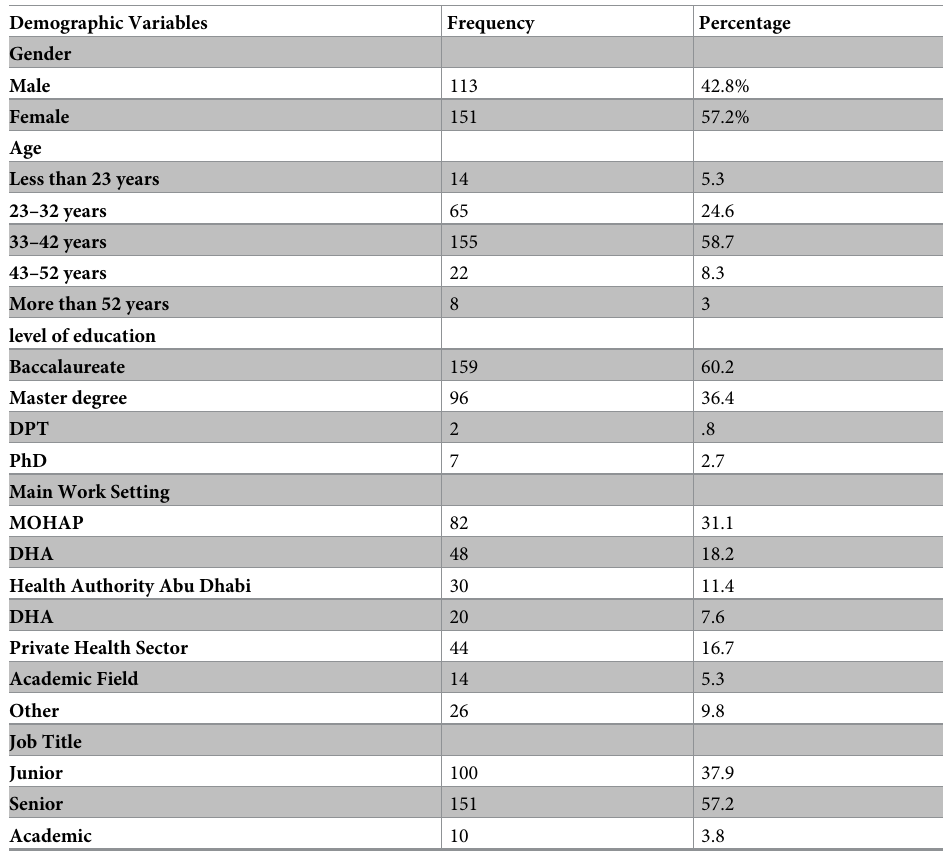
Table 1. Demographic profile of the respondents (n =